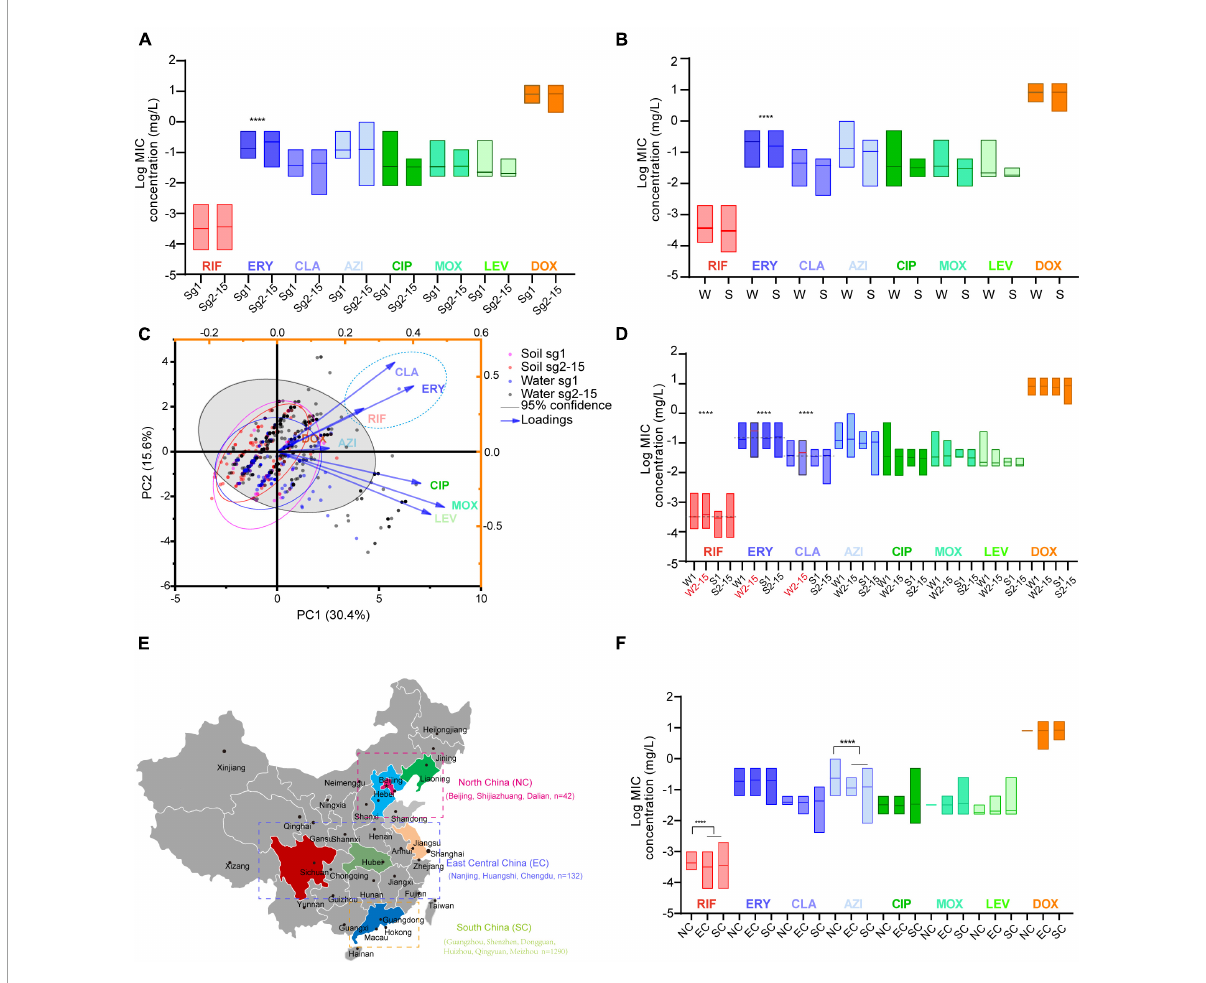
FIGURE2 Antimicrobial susceptibility profiles of L. pneumophila belonging to different sgs or from different environmental sources or regions in China. (A) Antibiotic susceptibility profiles of isolates belonging to different sgs. (B) Antibiotic susceptibility profiles of isolates from different sources. W, water sources; S, soil sources. (C) PCA biplot of MICs of the isolates. Isolates are shown as dots and colored by groups based on the sources and sgs. Indices are given as lines with arrows and colored. The configuration of indices in the biplot represents the relationship between variables and principal components. The gray shadow indicates 95% confidence for sg2-15 isolates from water sources. A dashed ellipse indicates significantly correlated variables. (D) Antimicrobial susceptibility profiles of isolates belonging to different sgs and from different sources. W1, sg1 isolates from water sources; W2-15, sg2-15 isolates from water sources; S1, isolates from soil sources; S2-15, sg2-15 isolates from water sources. Data are shown as floating bars with the max and min and mean values. Dotted lines indicate that log MICs are different in W2-15 isolates when compared with the other three types of isolates. (E) Regions of China where the tested isolates were obtained are shown. Cities where the isolates were obtained in each region are shown. (F) Antibiotic susceptibility profiles of isolates from different regions of China. Colored regions indicate the provinces where the isolates are from. We defined those MICs were 1.25 times higher/lower (log MIC gap > 0.969) than the contrast with P < 0.05 as significant. **** P <